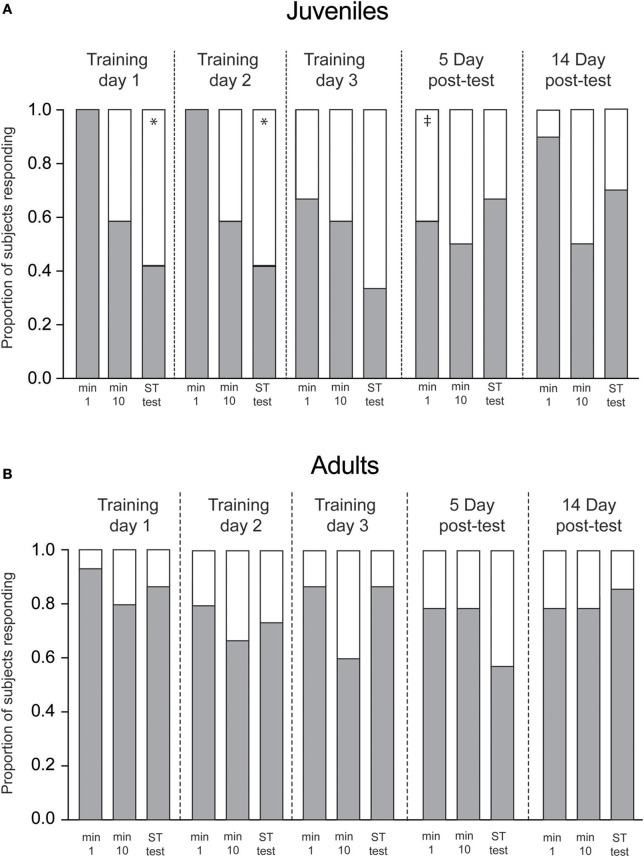
Proportion of response (gray) and non-response (white) to Presentation 1, 10 and short-term tests on each training day. (A) Juveniles (n = 12) showed significant declines in responses from the first presentation to the short-term memory test on Day 1 and Day 2. Long-term memory was present at the 5-day interval, but not the 14-day interval. (B) Adult squid showed no change in response/nonresponse rate over the training sequence. Bars show proportion of squid responding on each trial. Statistical comparisons made with Fisher's Exact Tests Comparisons within each day (min 1 vs. test, indicating short-term memory acquired within a trial) are denoted with *. Significant across trial comparisons for the first minute of Day 1 vs. first minutes on subsequent days (indicating long-term memory) are denoted with ‡.